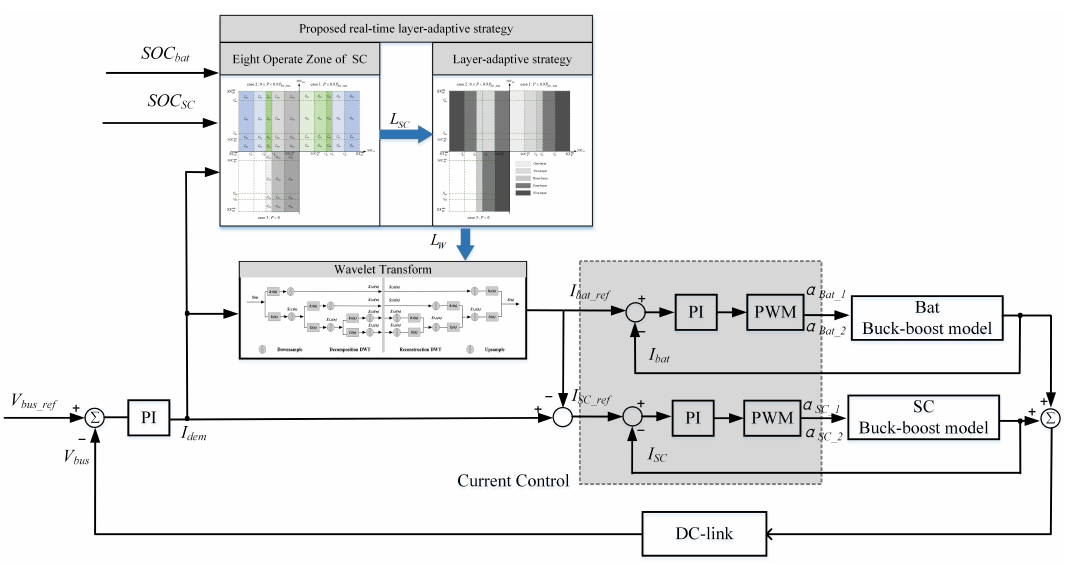
Figure 3. The proposed energy management system. The proposed strategy obtains the number of layers of wavelet transform and the bottom closed-loop control circuits track the reference current of batteries and supercapacitors.